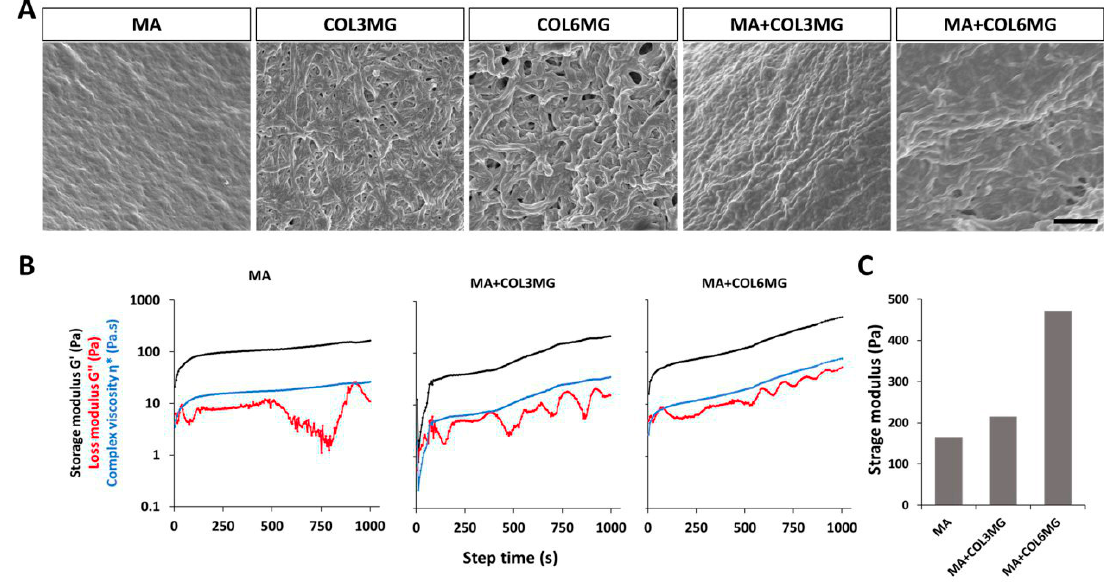
Figure 2. ( A ) SEM images of the hydrogel samples. Scale bar is 1 µ m. ( B ) The relationship between the concentration of collagen type I and sti ff ness of the hydrogels. ( C ) Sti ff ness was determined using rheometry. Note that MA + COL3MG and MA + COL6MG stand for 3 mg and 6 mg of collagen type I in hydrogel preparations, respectively. Note that SEM and rheometry analysis were performed with n = 1.